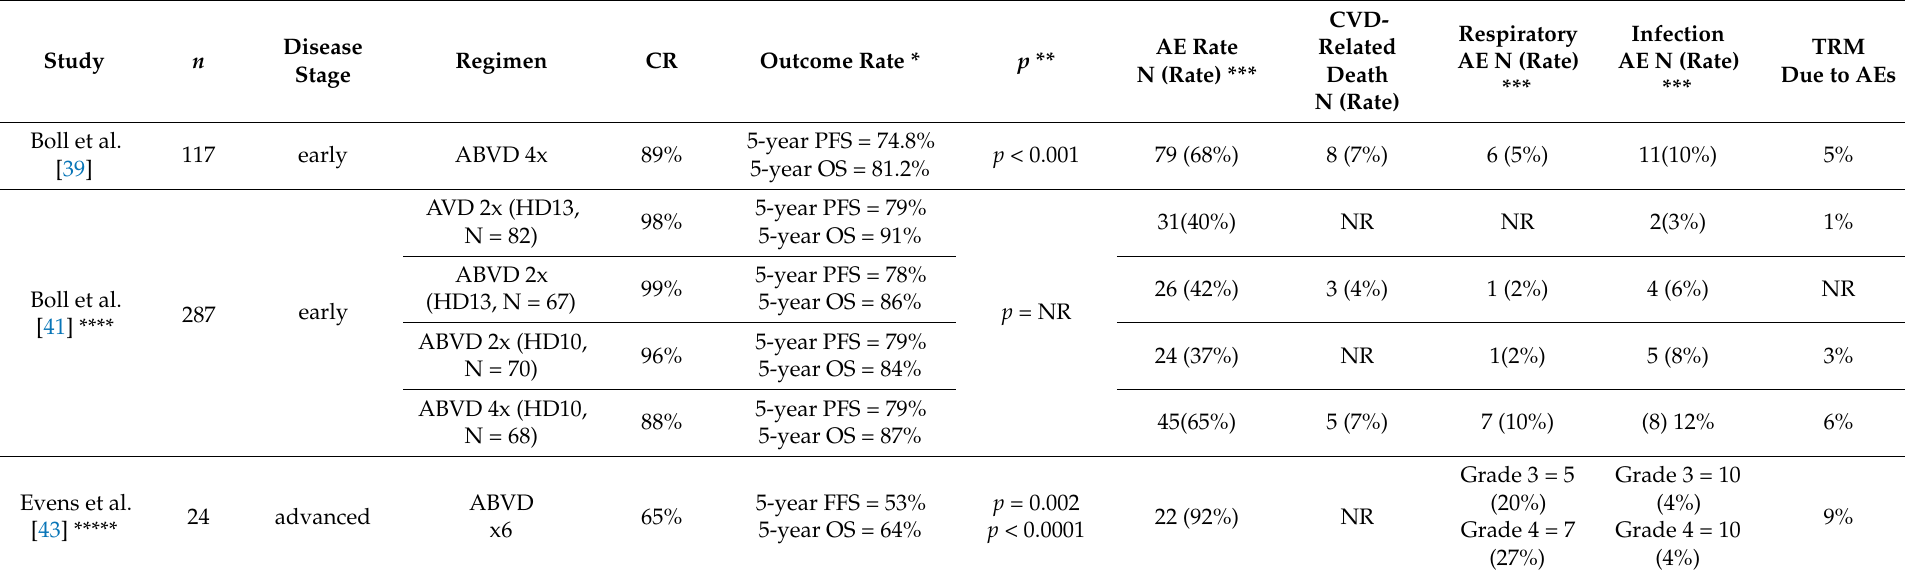
Table 2. ABVD Regimen in Elderly Hodgkin